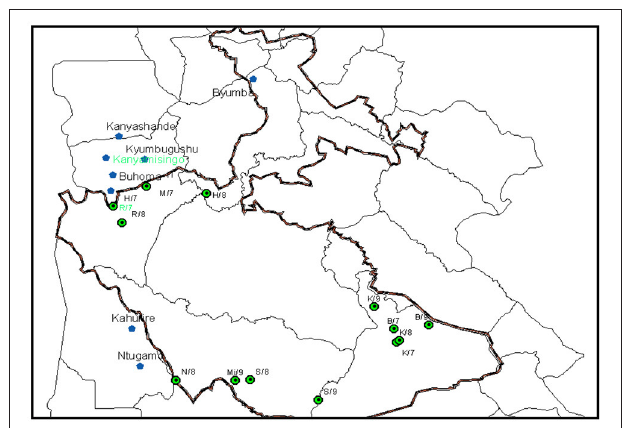
FIGURE 1 | Linking the gorilla (green) and livestock (blue) data points where samples were collected using GPS.